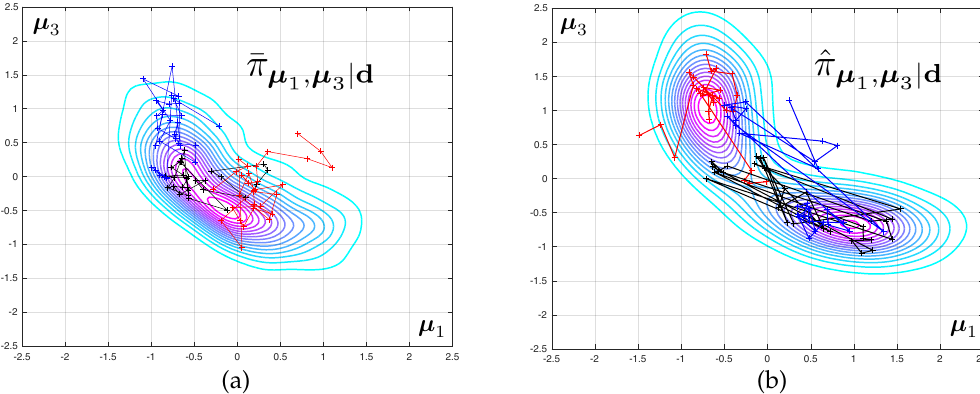
Figure 7. Multiple MCMC routines were run in parallel, for both the coarse likelihood function (coarse mesh) as shown in ( a ) and the enhanced likelihood function obtained after correction by the goal-oriented finite element error estimate, as shown in ( b ). The results are pooled, and will be boostrapped to derive confidence intervals for the summary statistics of the posterior